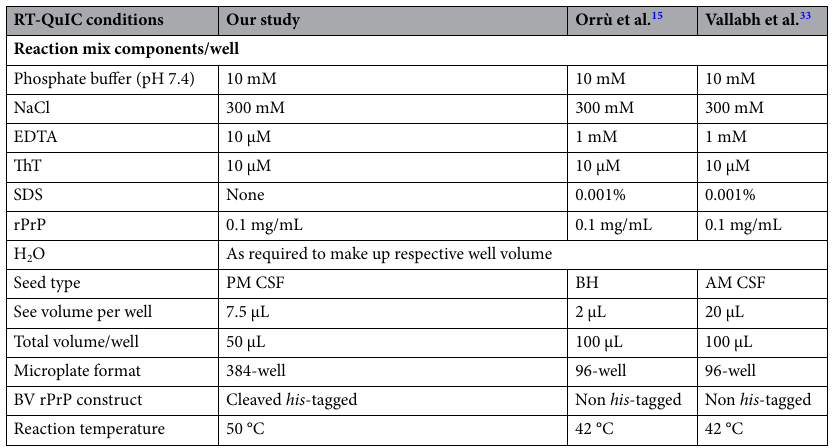
Table 3. Comparison of RT-QuIC key conditions used in this study against those of Orrù et al . 15 and Vallabh et al . 33 . NaCl sodium chloride, EDTA ethylenediaminetetraacetic acid, ThT thioflavin T, SDS sodium dodecyl sulphate, rPrP recombinant prion protein, PM CSF post mortem cerebrospinal fluid, AM CSF ante mortem cerebrospinal fluid, BH brain homogenate, his-tagged